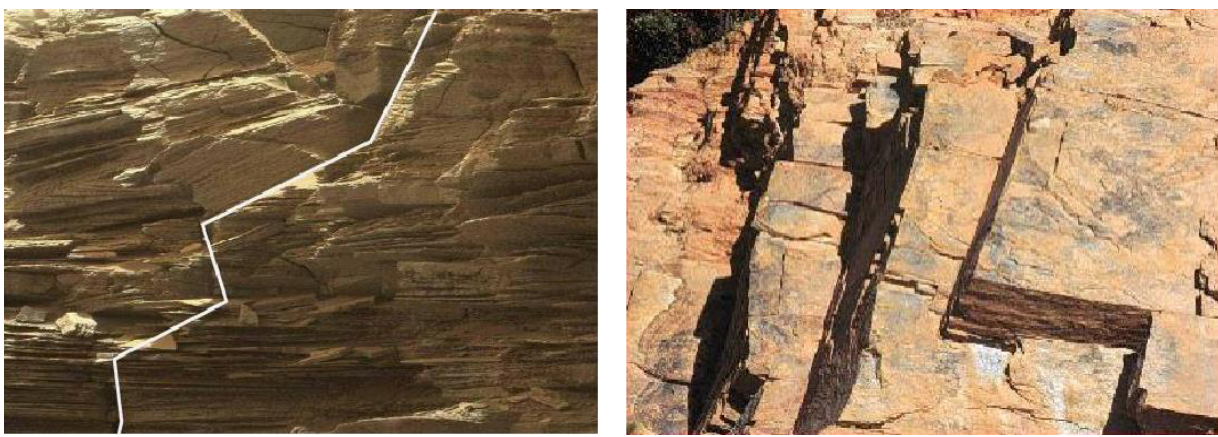
Figure 1. Natural irregular sawtooth rock discontinuity [7].